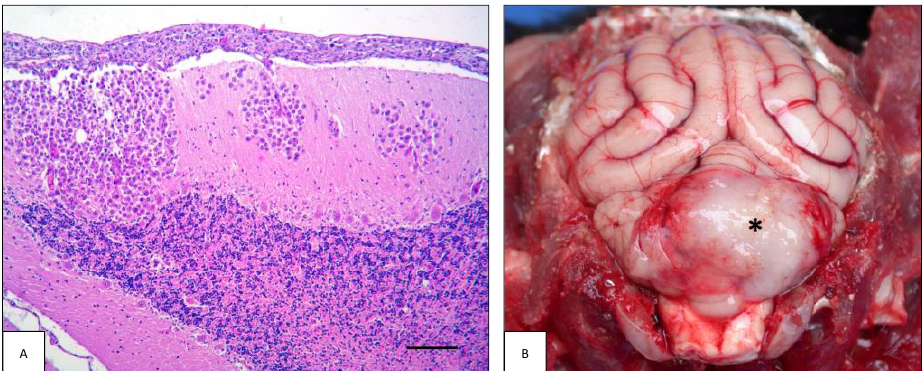
Figure 4. Intracranial lymphoma: leptomeningeal lymphomatosis. ( A ) Case #40. Dog brain section in which neoplastic cells diffusely infiltrate the cerebellar leptomeninges and multifocally invade the molecular layer (H&E, bar = 100 µm). ( B ) Case #49. Cat brain, the surface of the cerebellum is covered by a whitish and thick layer histologically composed of neoplastic cells (asterisk).